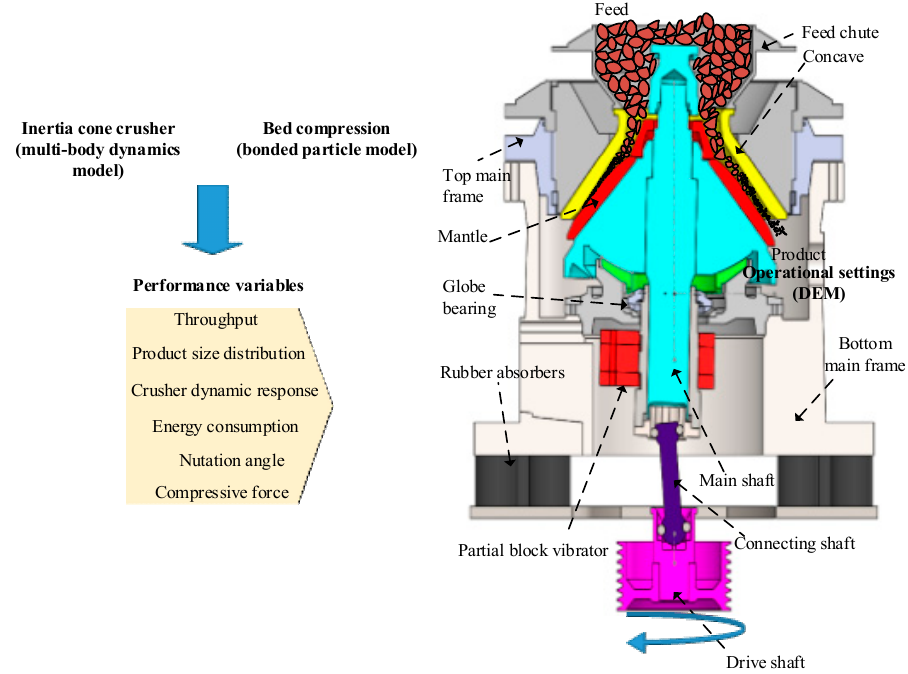
Figure 1. Schematics of the inertia cone crusher and the general scheme of the model, as well as its